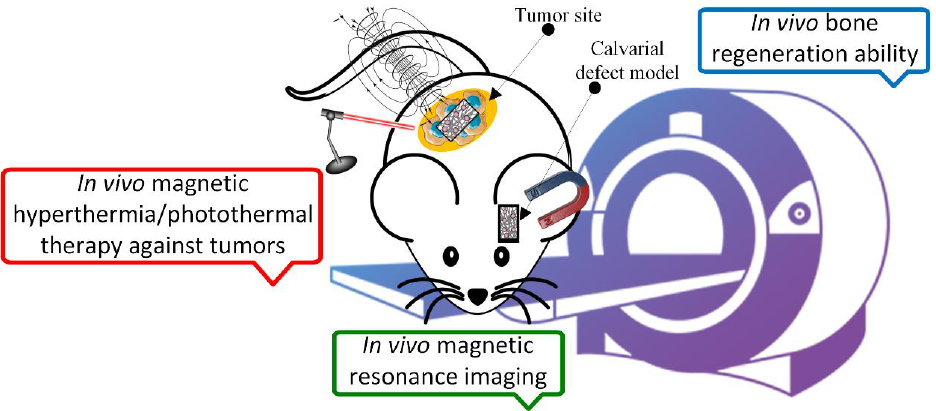
Figure 12. Representation of the main function of the magnetic scaffold applied for in vivo